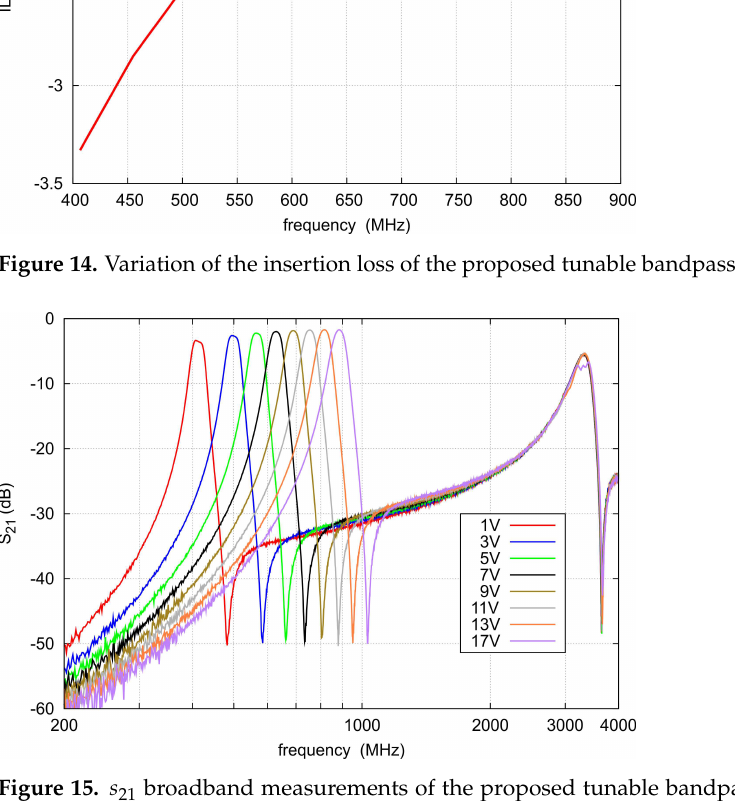
Figure 15. s 21 broadband measurements of the proposed tunable bandpass filter for the selected control